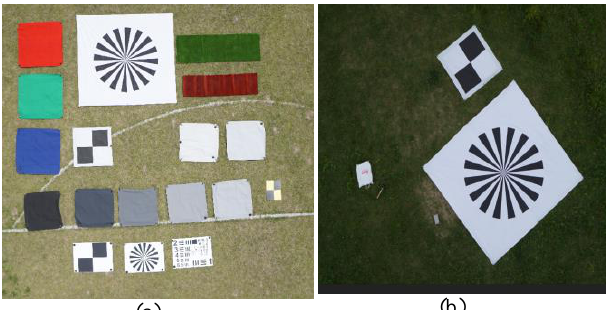
Figure 2. Experimental places for image acquisition : (a) first and second place; (b) third place